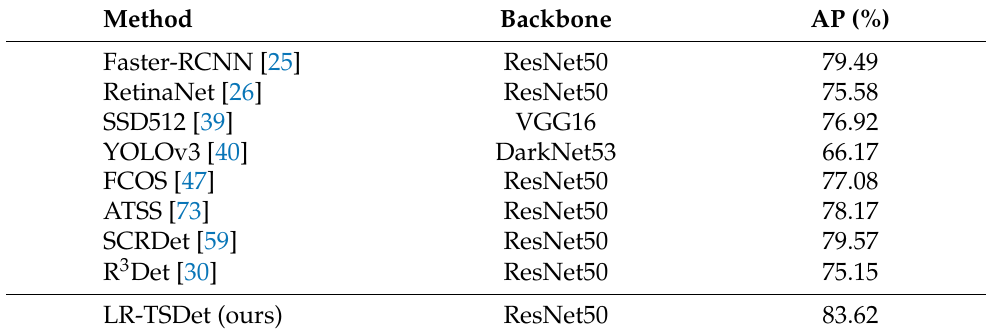
Table 7. Comparisons with other typical methods on the DOTA-Ship